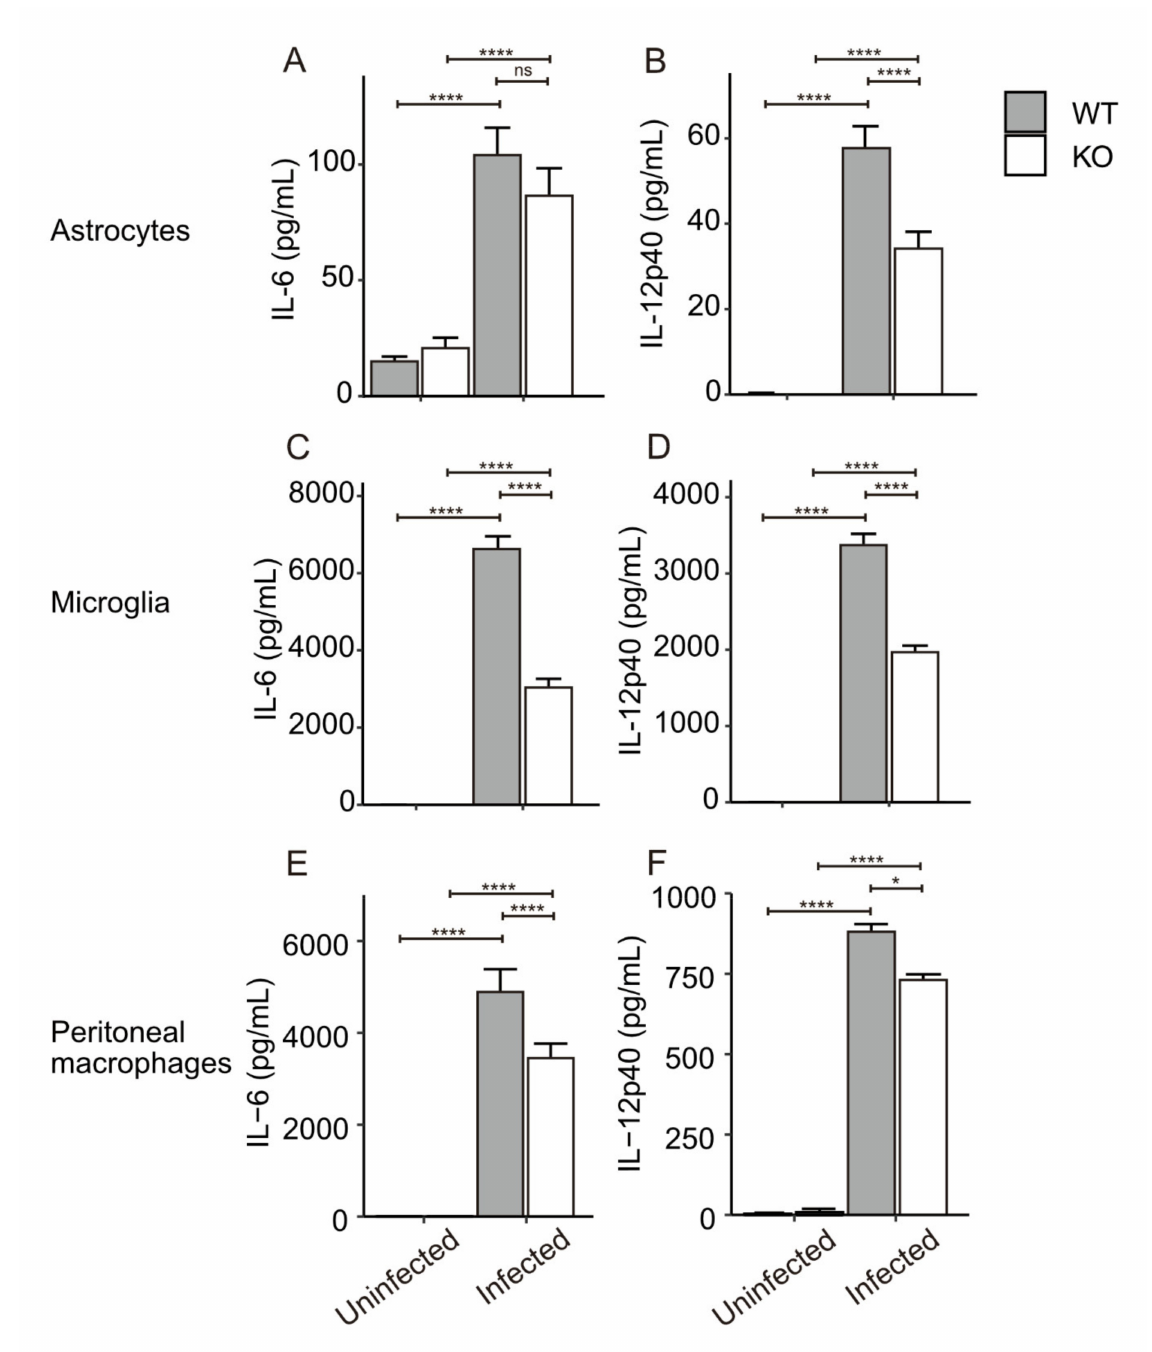
Figure 5. Cytokine production from primary astrocytes, microglia and macrophages during T. gondii infections. Primary astrocytes ( A , B ), microglia ( C , D ), macrophages ( E , F ) were infected with T. gondii tachyzoites for 24 h at MOIs of 1.0, 1.0, and 0.2, respectively. Cells were prepared in four replicate wells for each group. Bars and error bars represent the mean ± SD. ns, p > 0.05, * p < 0.05, **** p < 0.0001 (two-way ANOVA with post-hoc Tukey’s test). These experiments were repeated twice and the representative data were